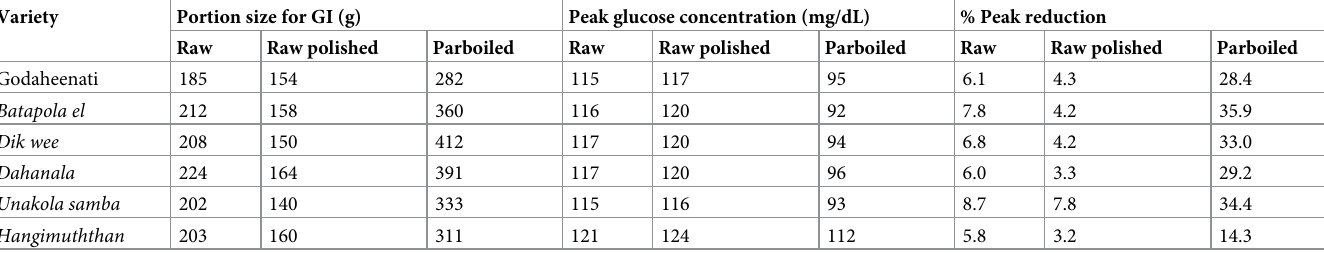
Table 3. Portion size for GI, peak blood glucose and % peak reduction compared to glucose. Variety Portion size for GI (g)